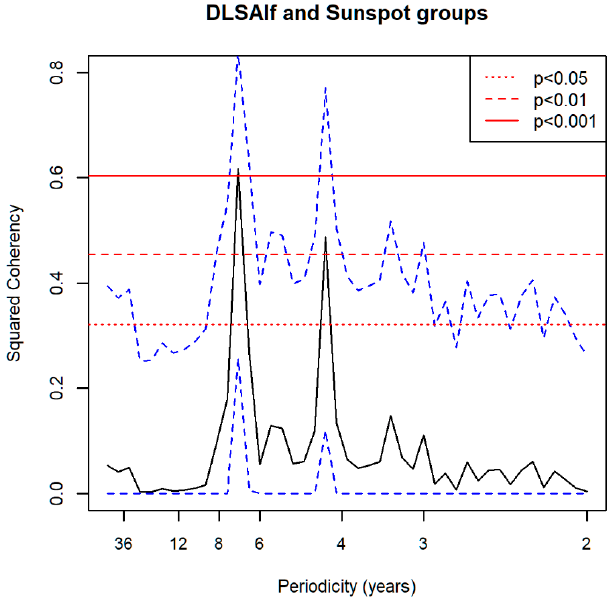
Figure 11. Squared coherency of the sunspot groups and DLSAlf (the low frequency component of DLSA, the 1° gridded data (1930–2014)). The solid horizontal red line indicates significance at p = 0.001, dashed line p = 0.05, dotted line p = 0.05. The blue dotted lines represent 95% confidence